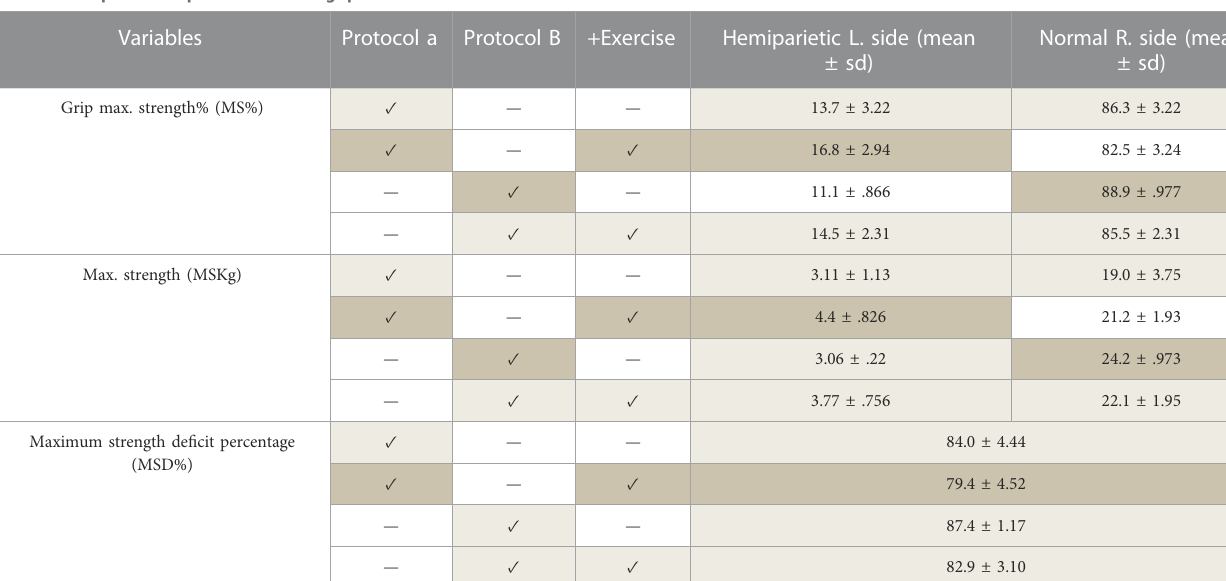
TABLE 5 Comparison of protocols for the grip